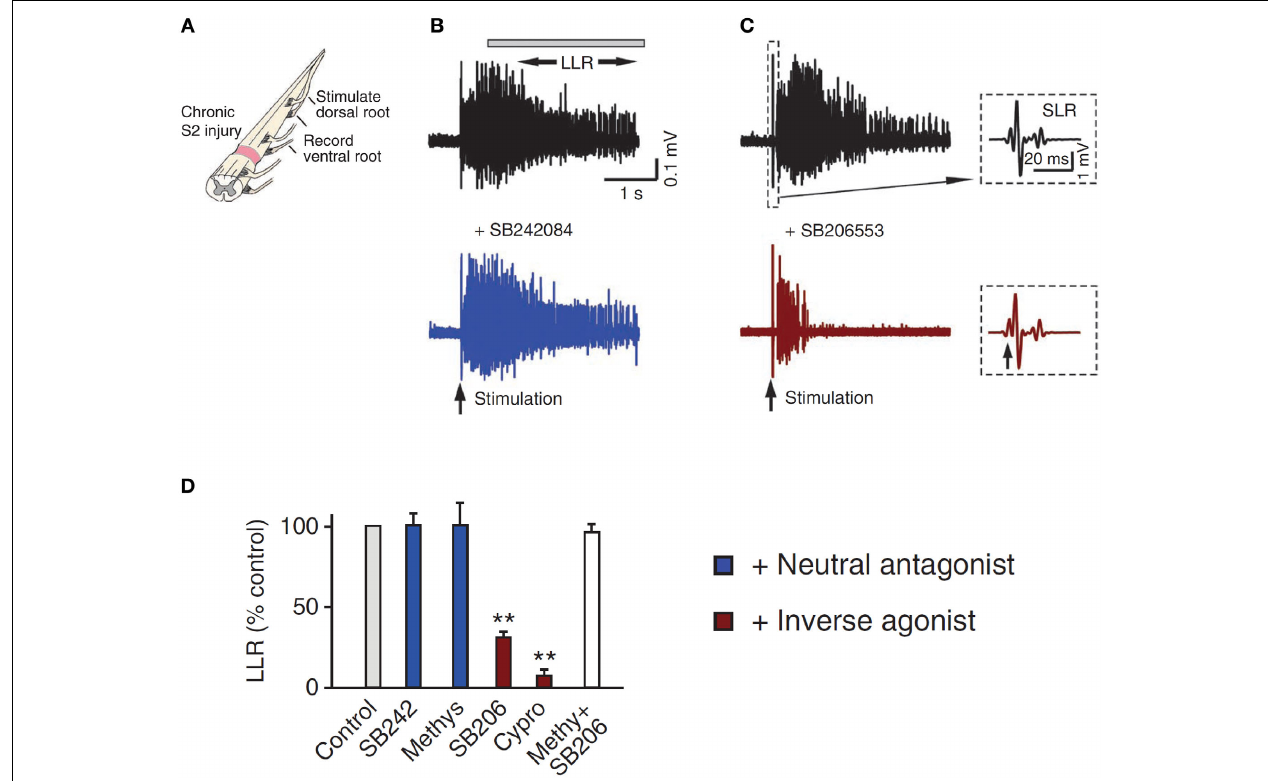
FIGURE 6 | Constitutive receptor activity in chronic SCI rat. (A) In vitro ventral root recordings in response to single-pulse (3 × T) dorsal root stimulation in chronically spinalized (S2) rats. (B) PIC-mediated long-lasting reflex (LLR: 500–4000ms after stimulation) before (black trace) and after (blue trace) application of the neutral antagonist SB242084. (C) Evoked LLR before (black trace) and after (red trace) application of the inverse agonist SB206553. Inset shows the sensory